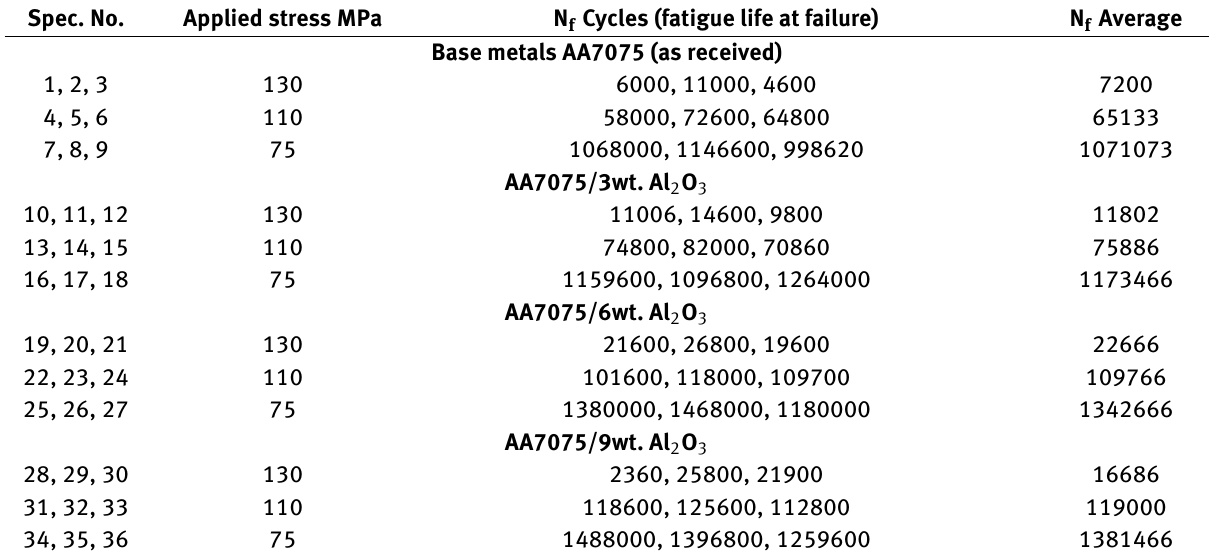
Table 4: S-N curve life for base metal and nano composites Spec. No.